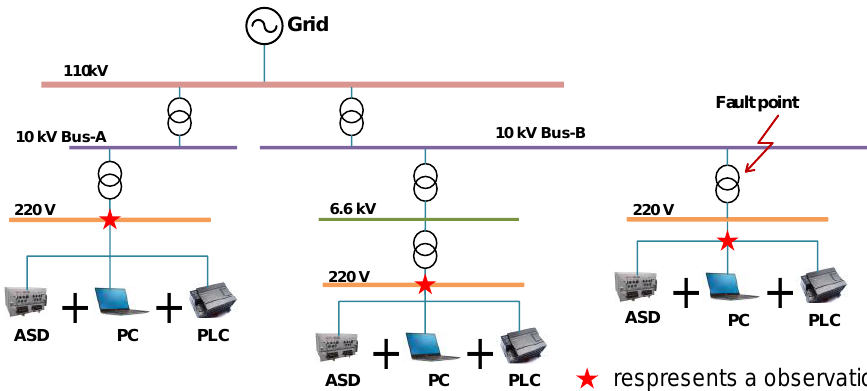
Figure 5. Industrial distribution network.